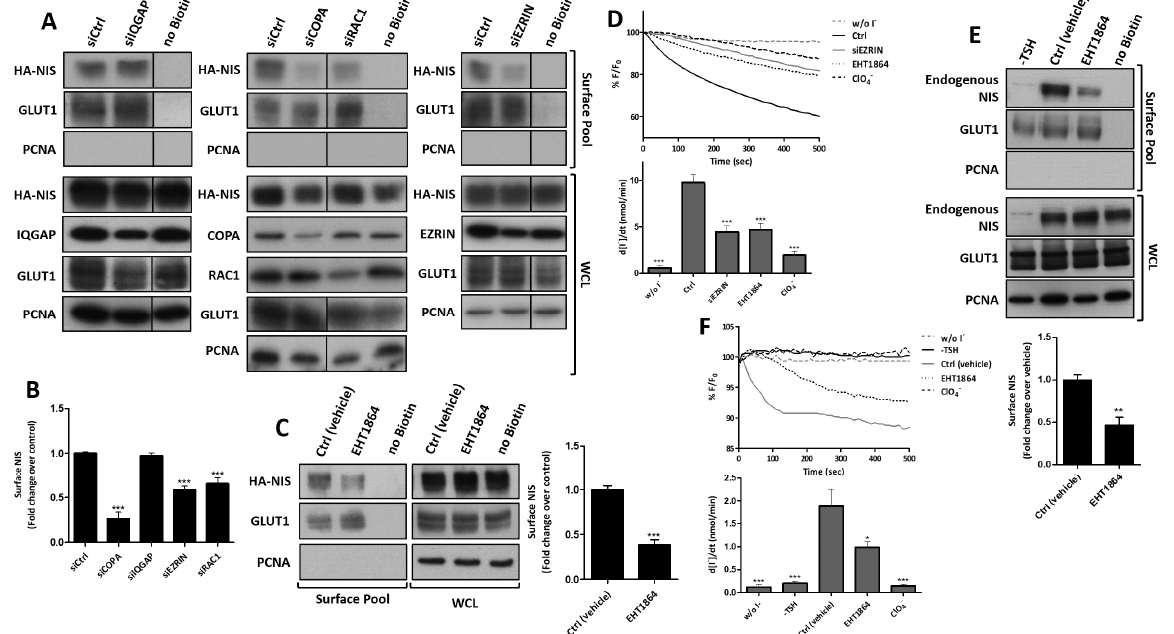
Figure 4. Effects of IQGAP, COPA, RAC1 and EZRIN depletion on the NIS abundance at the PM. ( A ) HA-NIS-TPC1 cells were transfected with siRNAs targeting IQGAP, COPA, EZRIN and RAC1, and were analyzed by cell-surface protein biotinylation. The HA-NIS protein in either the surface fraction or the correspondent whole-cell lysates (WCL) was detected by WB. The ‘no Biotin’ condition, corresponding to cells that were not incubated with biotin, was used to control the specificity of the biotinylated protein pull-down. WCL were further probed for IQGAP, COPA, RAC1 and EZRIN protein levels, in order to ascertain siRNA efficiency. PCNA detection served as the loading (WCL) and intracellular protein contamination control (Surface pool). GLUT-1 served as the positive loading control for the cell surface protein extracts. ( B ) Surface HA-NIS expression was quantified by the densitometric analysis of the WB bands, using ImageJ software. The plotted values are means ± SEM of three independent assays. The one-way ANOVA analysis detected significant differences between the treatments (F = 33.17; p < 0.001). Post-hoc Dunnett’s tests were used to identify significant variations relative to ‘siCtrl’ (transfection with a siRNA against luciferase firefly–see Materials and Methods) (*** p ≤ 0.001). ( C ) HA-NIS-TPC1 cells were treated with 50 µ M EHT1864 for 1 h and analyzed by cell-surface protein biotinylation followed by WB, as in ( A ). The surface HA-NIS expression was quantified by the densitometric analysis of the WB bands, as before. A Student T test was used to evaluate significant variations relative to the ‘Ctrl’ sample (*** p ≤ 0.001). ( D ) HA-NIS-TPC1 cells stably co-expressing the HS-YFP iodide sensor were transfected with either siCtrl or siEZRIN, or treated or not with 50 µ M EHT1864 for 1 h, or 50 mM of ClO 4 − for 10 min, and the YFP fluorescence was recorded continuously, as described in the legend to Figure 1. The data are the means ± SEM of five independent assays. One-way ANOVA analysis detected significant differences between the treatments (F = 33.39 and p < 0.001). Post-hoc Dunnett’s tests were used to identify significant variations relative to the control (Ctrl) conditions (*** p ≤ 0.001). ( E ) PCCL3 thyroid cells were serum-starved for 24 h, followed by stimulation or not with TSH (1 mU/mL for 48 h). The cells were then treated with either vehicle or 50 µ M EHT1864 for 1 h, and were analyzed by surface protein biotinylation and WB, as in ( A ). The plotted values are the means ± SEM of three independent assays. Significant variations were assessed by Student T test (** p ≤ 0.01). ( F ) PCCL3 cells stably expressing the HS-YFP iodide sensor were stimulated as in ( E ), and were treated or not with 50 µ M EHT1864 for 1 h, or 1 mM of ClO 4 − for 10 min, and their YFP fluorescence was recorded continuously, as described in the legend to Figure 1. The data are the means ± SEM of five independent assays. One-way ANOVA analysis detected significant differences between the treatments (F = 18.13 and p < 0.001). Post-hoc Dunnett’s tests were used to identify significant variations relative to the control (Ctrl) conditions (* p ≤ 0.05; *** p ≤